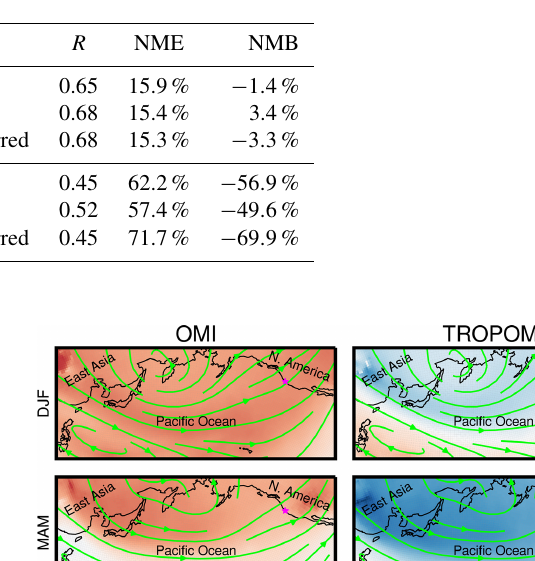
Table 2. CMAQ model performance evaluated against daily average NO 2 (DA NO 2 ) and maximum 8h O 3 concentrations (MDA8 O 3 ) observed in 2019 by AQS monitoring sites in the US. Near-road monitors are not considered. Statistics are shown for simulations using prior emissions (Prior), lightning and anthropogenic NO x emissions inferred with OMI data (OMI-inferred), and lightning and anthropogenic NO x emissions inferred with TROPOMI data (TROPOMI-inferred). Coefficient of determination ( R ), normalized mean error (NME), and normalized mean bias (NMB), relative to AQS observations, are estimated for each CMAQ simulation.